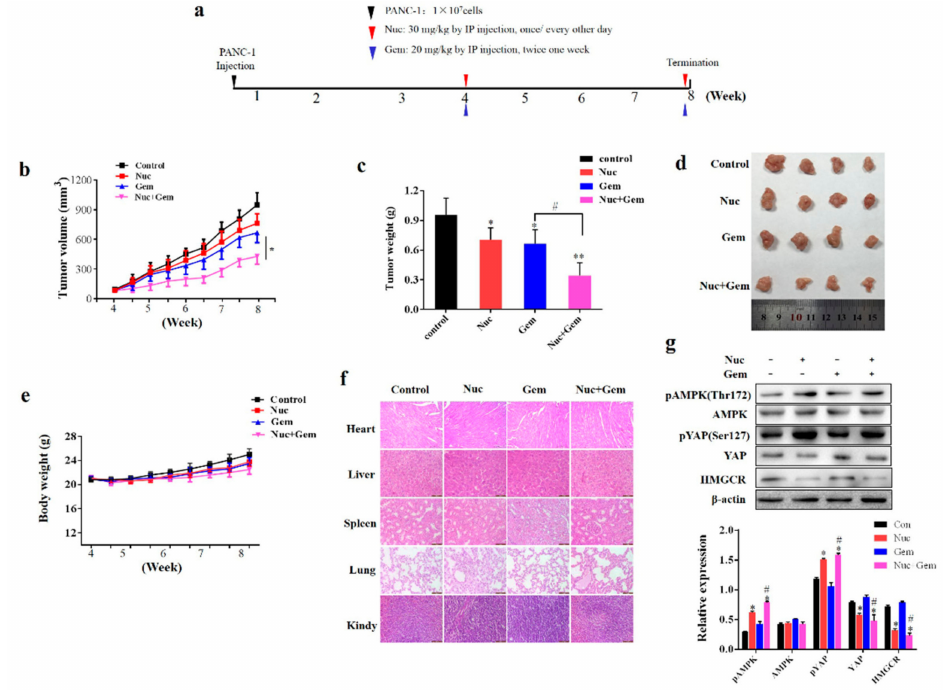
Figure 6. Nuciferine enhances gemcitabine e ffi ciency in vivo . ( a ) PANC-1 cells were injected into mice (n = 4 mice per group) on day 0, and nuciferine or gemcitabine was administered as indicated. ( b ) Tumor volume was measured on the indicated time points. ( c , d ) At the end of the experiment, pancreatic tumor tissues were excised, photographed, and weighted. ( e ) Body weights of the mice were monitored over the treatment period. ( f ) HE staining of the major organs, Scale bars: 100 µ m. ( g ) Western blot analysis on the expression of AMPK, pAMPK(Thr172), YAP, pYAP(Ser127) and HMGCR from respective tumor tissue lysates and relative density was determined. Nuc, nuciferine, Gem, gemcitabine. * p < 0.05 or ** p < 0.01 compared with control and # p < 0.05 compared with Gem